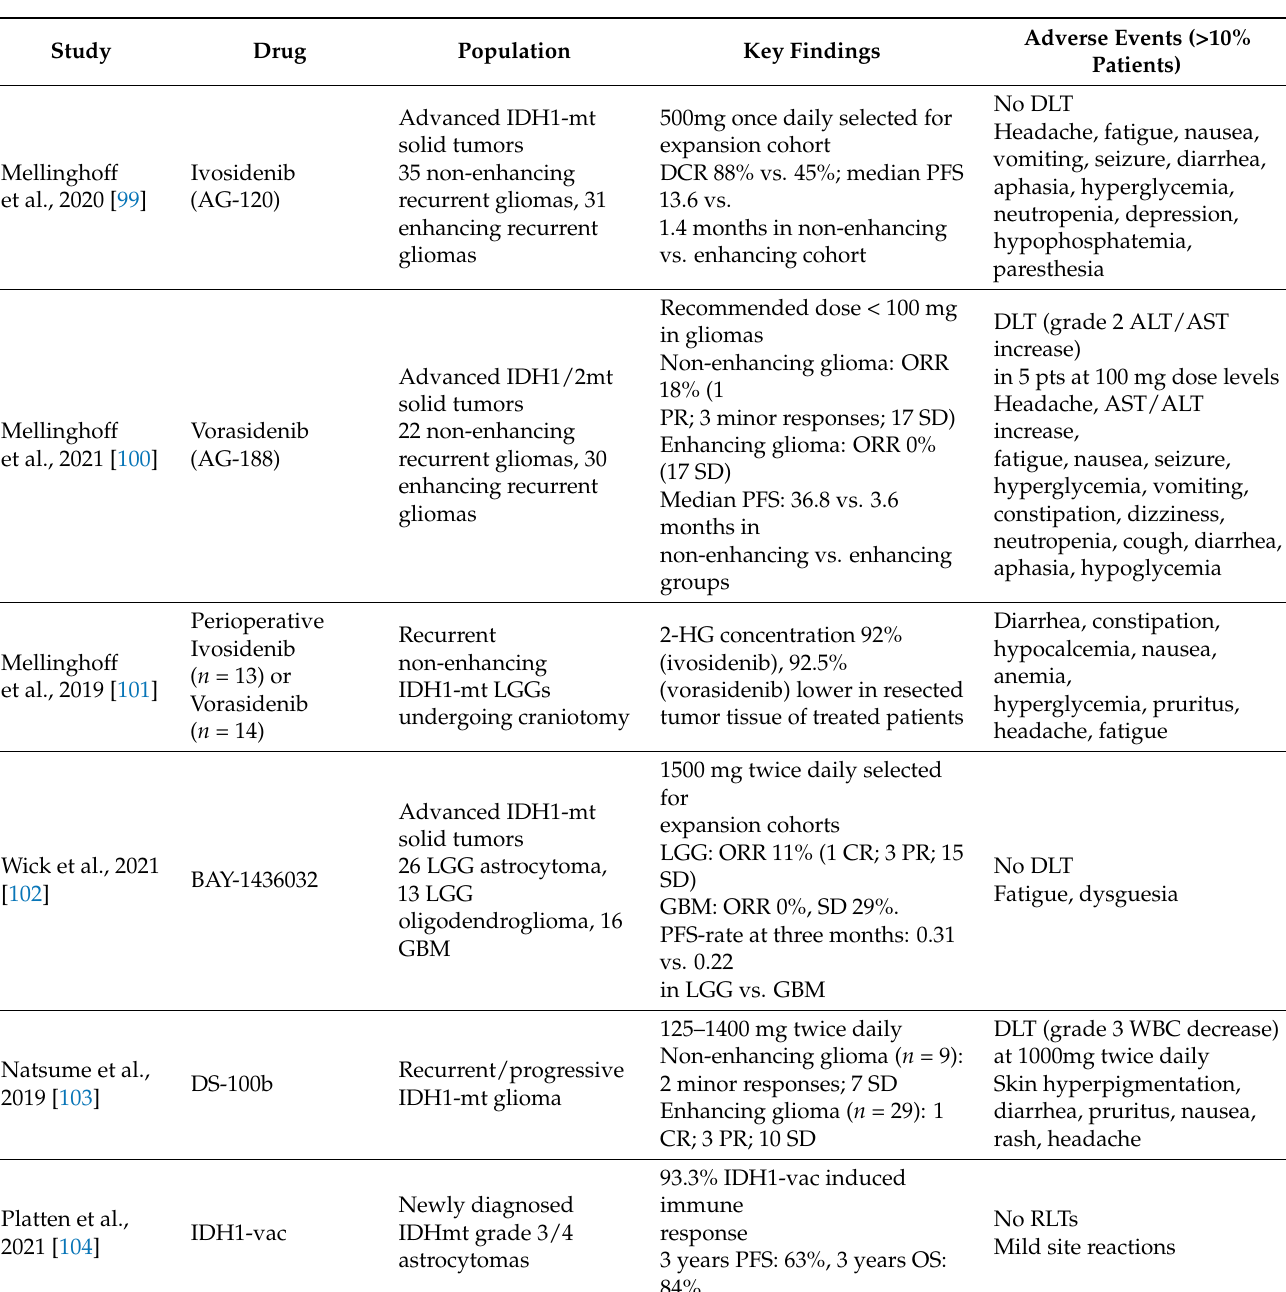
Table 3. Completed clinical trials with IDH-targeted therapies in glioma cells. Adapted